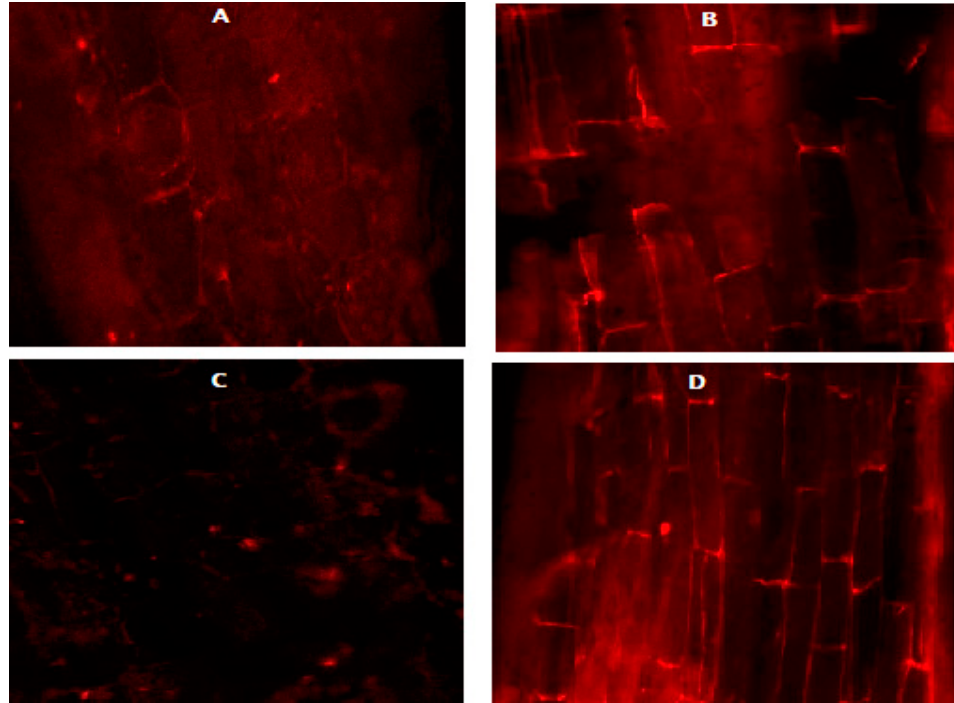
Figure 10. Confocal micrographic images of the root cells of carrot at U150 ( A ) and its control ( B ) and root cells of beetroot at U150 ( C ) and its control ( D ).